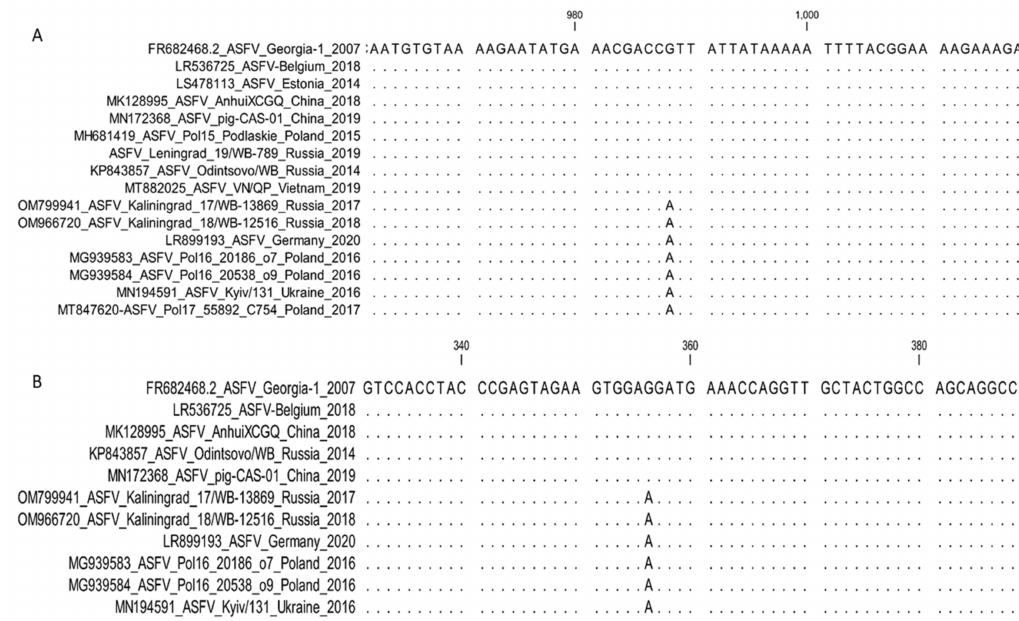
Figure 8. Nucleotide alignment of ASFV isolates based on the analysis of the partial sequence of ( A ) MGF-505-5R and ( B ) MGF-110-7L , showing the SNP in these regions among genotype II